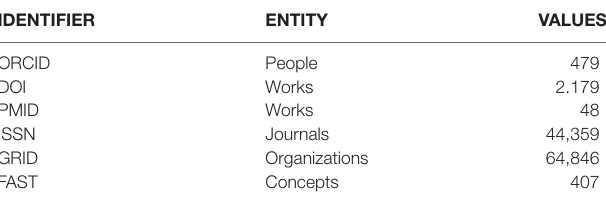
TAble 1 | The use of persistent identifiers in